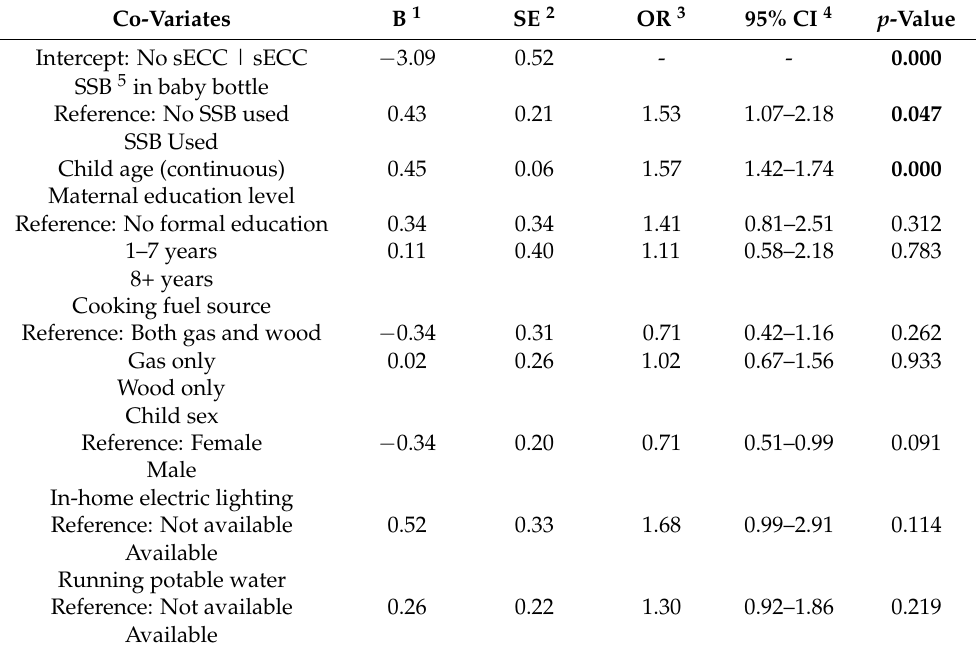
Table 5. Risk factors for severe early childhood caries (sECC) outcome ( n =